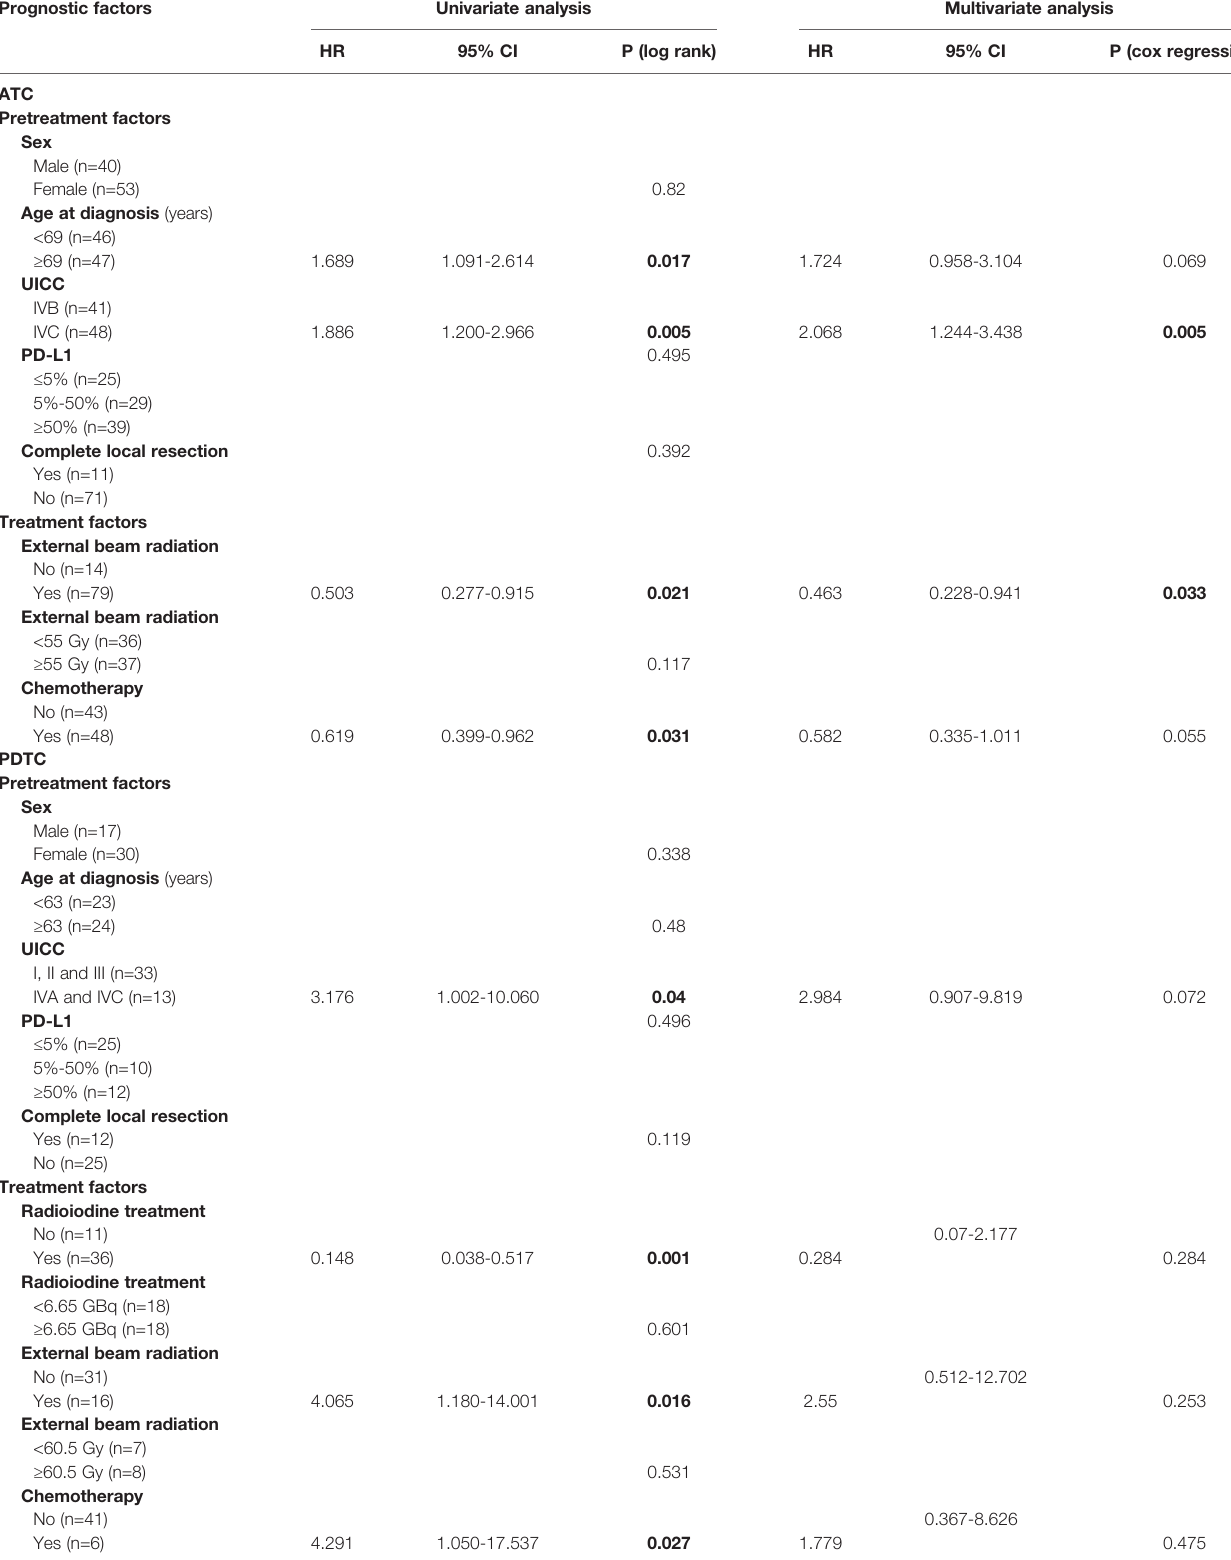
TABLE 4 | Impact of PD-L1 expression and clinical parameters on disease speci fi c death from